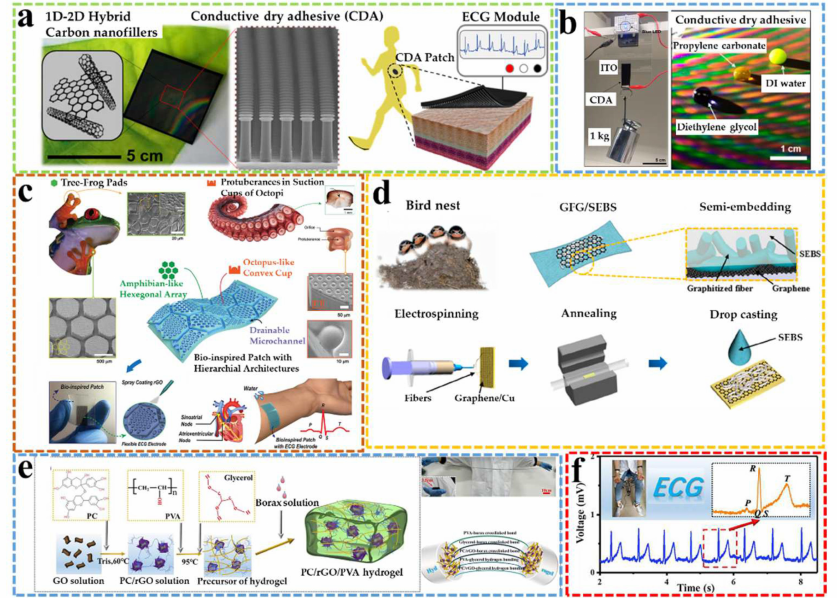
Figure 1. Bionic graphene ECG electrodes. ( a ) Gecko-inspired ECG electrodes. Reprinted with permis- sion from Ref. [36]. Copyright 2016, American Chemical Society. ( b ) Photo of the strong adsorption of the CDA electrode ( left ) and liquid droplets on the gecko-inspired CDA electrode ( right ). Reprinted with permission from Ref. [36]. Copyright 2016, American Chemical Society. ( c ) Amphibian- and octopus-inspired hierarchical hexagonal microstructures for ECG monitoring. Reprinted with per- mission from Ref. [40]. Copyright 2016, American Chemical Society. ( d ) An avian-nest-inspired ECG electrode and its preparation process. Reprinted with permission from Ref. [42]. Copyright 2020, American Chemical Society. ( e ) Schematic of the preparation process ( left ) and the ultra-fast self- healing ability ( right ) of the PC/rGO/PVA hydrogel ECG electrode. Reprinted with permission from Ref. [43]. Copyright 2020, Elsevier. ( f ) The self-healing ECG electrode is used to detect ECG signals. Reprinted with permission from Ref. [43]. Copyright 2020,